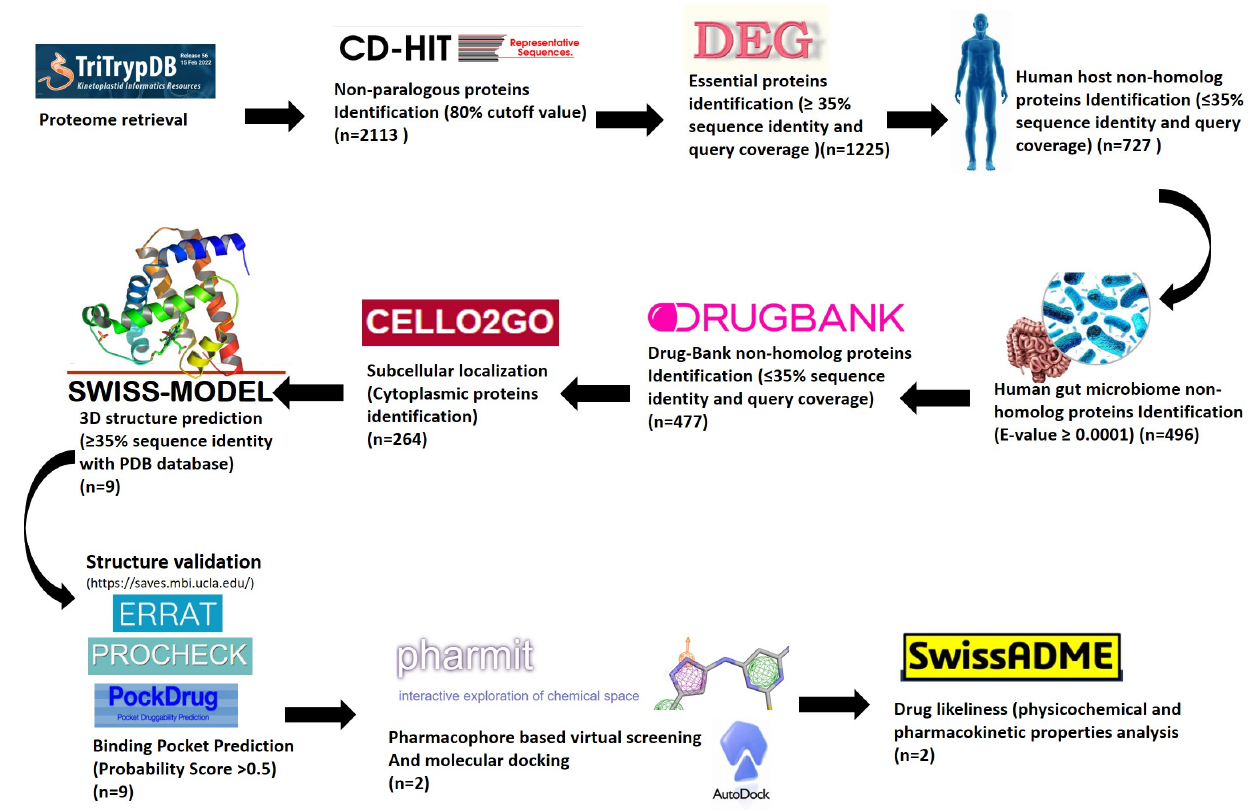
Figure 1. Flowchart diagram of the methodological steps pursued during this study. ‘n’ represents the number of proteins shortlisted in each step.